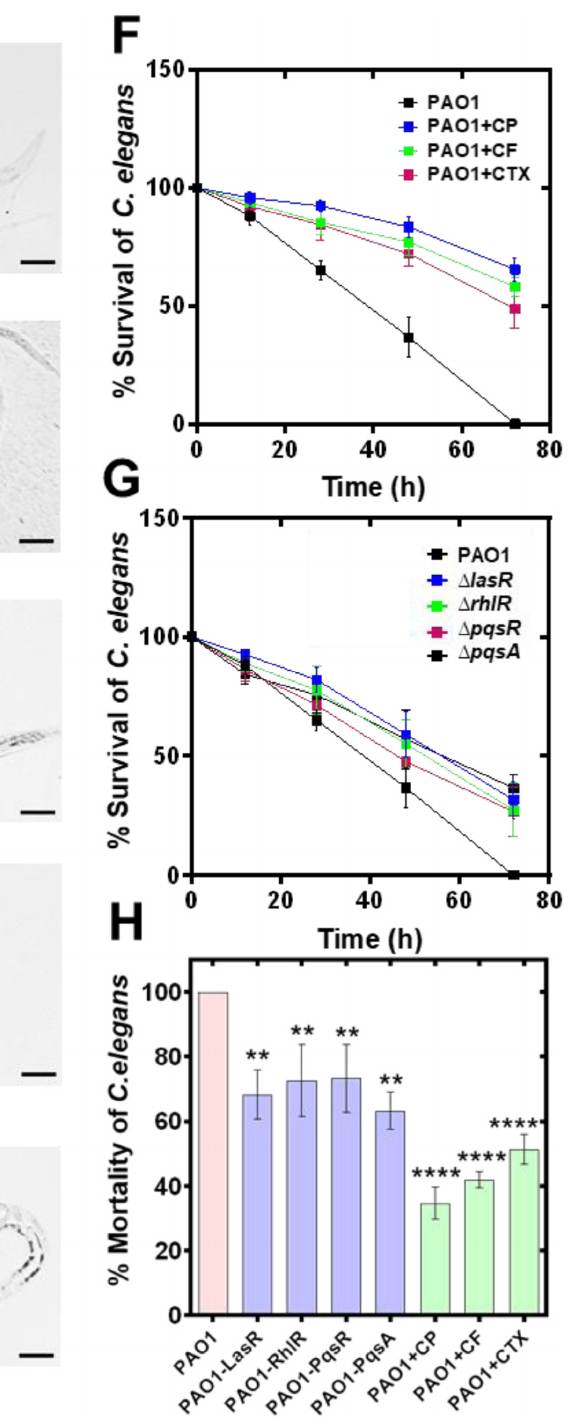
Frontiers in Microbiology |